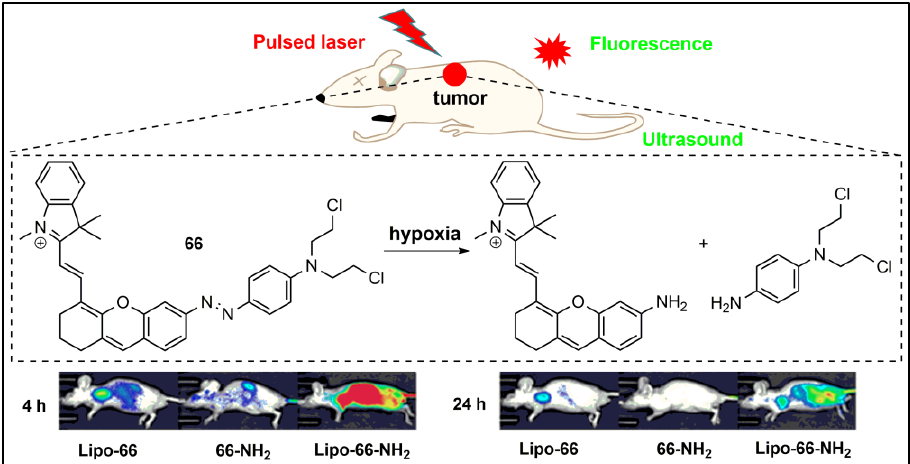
Figure 62. Illustration of the response of 66 toward hypoxia in tumor-bearing mice model. Typical fluorescence images of HepG2 xenograft tumor-bearing mice upon intravenous injection of 66 -NH 2 (in PBS containing 1 % DMSO), Lipo- 66 (in PBS), and Lipo- 66 -NH 2 (in PBS) for 4 h and 24 h. Adapted with permission from [172]. Copyright (2019) Ivyspring International Publisher.